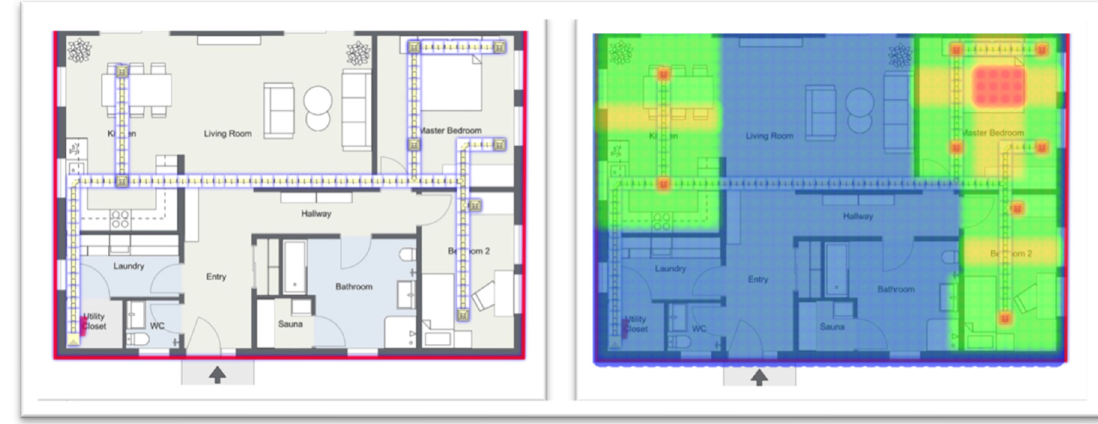
Figure 2. BIMcpd—HVAC Ducting Placement and